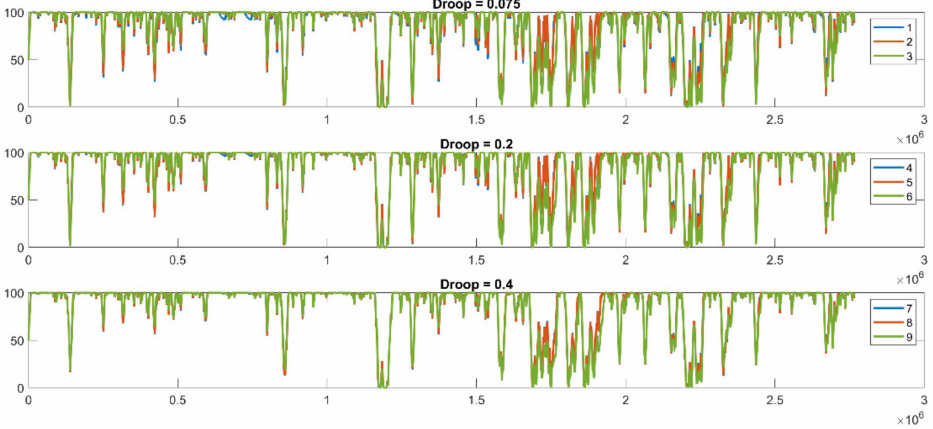
Figure 12. The SOC trend over time (cases